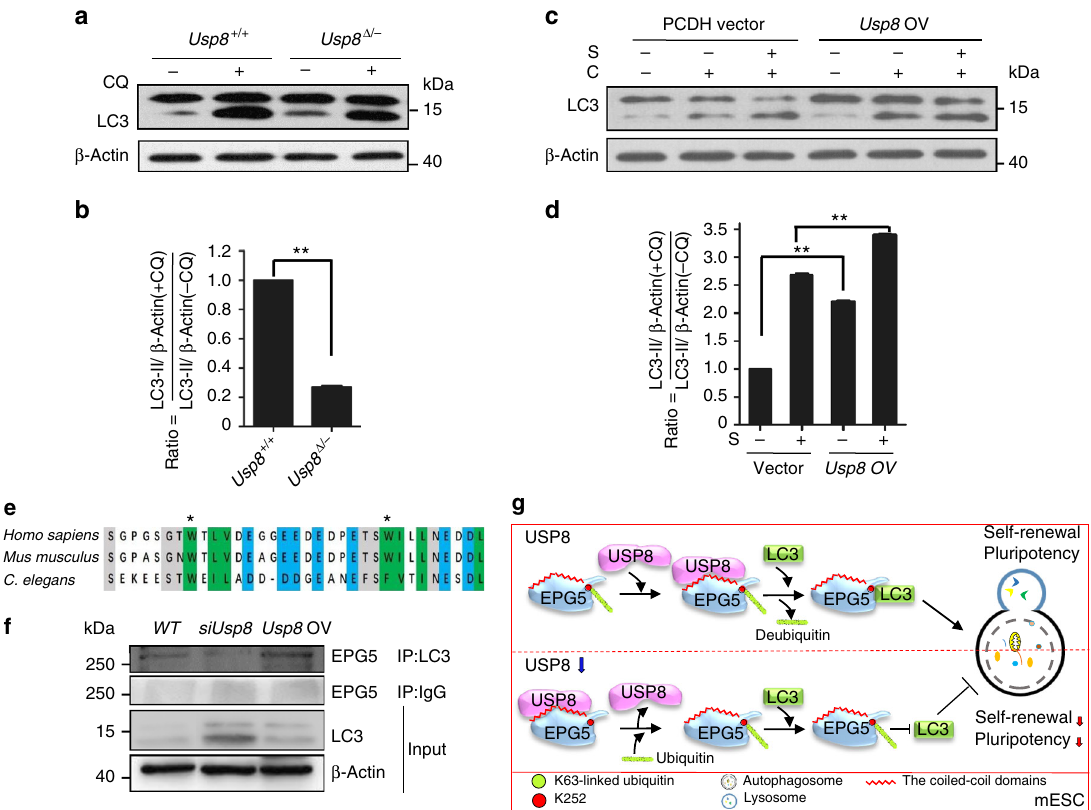
Fig. 6 USP8 dynamically regulates the EPG5-LC3 interaction. a Western blotting for LC3 and β -actin in Usp8 + / + and Usp8 ▵ / − ESCs. β -Actin served as the loading control. Cells were treated with 50 μ M chloroquine (CQ) for 2 h. b Quanti fi cation of autophagic fl ux in a by calculating the ratio of LC3-II with or without CQ treatment. Error bars indicate the SD ( n = 3). Three independent biological replicates. ** P < 0.01 by unpaired two-tailed Student ’ s t test. c Western blotting for LC3 and β -actin in WT and Usp8 -overexpression stable ESCs upon nutrient deprivation. β -Actin served as the loading control. Cells were treated with 50 μ M chloroquine (C) for 2 h and/or starved (S) in EBSS for 2 h. d Quanti fi cation of autophagic fl ux by calculating the ratio of LC3-II with or without CQ treatment in c . Error bars indicate the SD ( n = 3). Three independent biological replicates. ** P < 0.01 by unpaired two-tailed Student ’ s t test. e Sequence alignment of the LC3-binding region (LIR) in human, mouse, and C. elegans EPG5 proteins. The aromatic residues in the two LIR motifs are indicated by asterisks. Conserved hydrophilic residues are in gray, conserved hydrophobic residues are in green, and conserved negatively charged residues are in blue. f Lysates of Usp8 -overexpression and si Usp8-knockdown ESCs were immunoprecipitated with anti-LC3 or anti-IgG and immunoblotted with anti-EPG5 and anti-IgG antibodies. Input cell lysates were immunoblotted with anti-LC3 and anti-actin antibodies as controls. Cells were starved for 2 h before analysis. g A proposed model of the role of the USP8-EPG5-LC3 pathway in regulating ESC